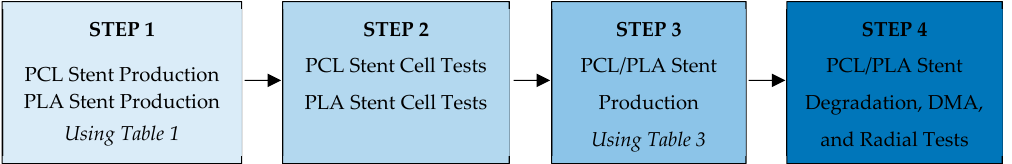
Figure 3. Methodology followed to carry out the experiments. DMA: Dynamic Mechanical